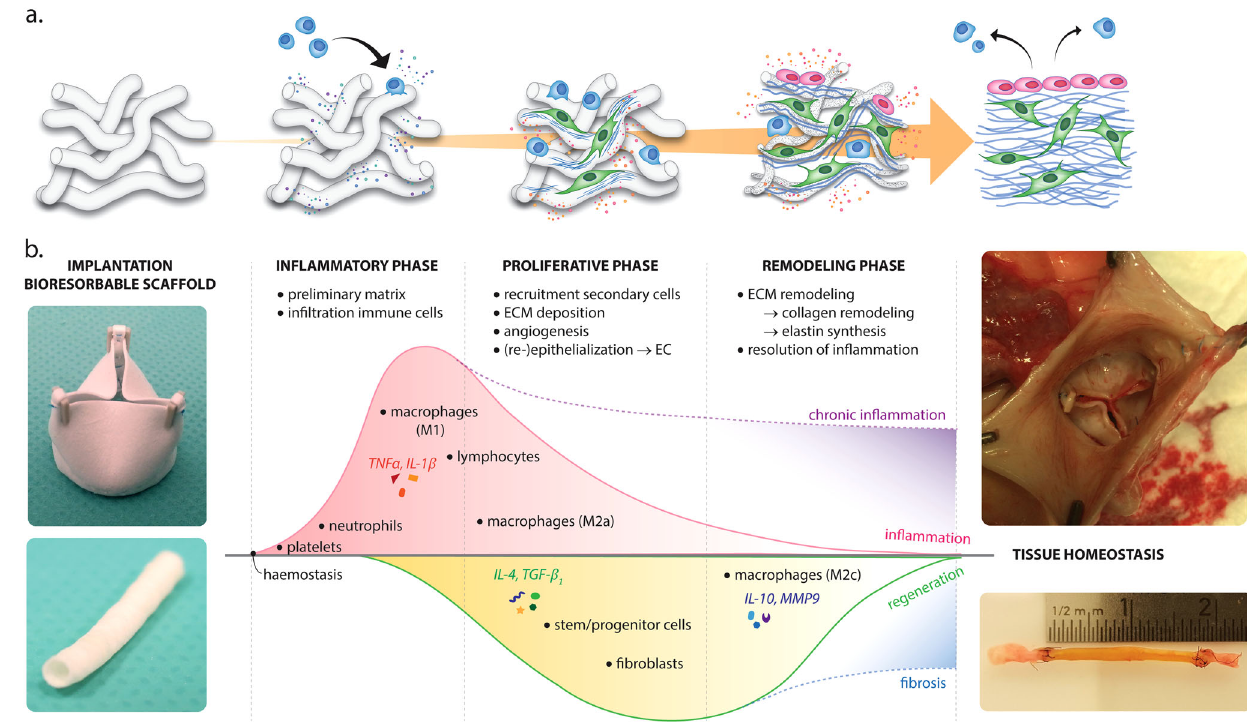
Fig. 1 Overview of the different stages of in situ tissue regeneration, going from a synthetic, biodegradable bare construct toward a viable substitute ( a ). Although many aspects underlying in situ regeneration remain unknown, it is hypothesized that the stages mirror the natural phases of the wound healing response ( b ), starting with the in fl ammatory phase, characterized by the in fi ltration of immune cells and the formation of a preliminary matrix. The subsequent proliferative phase is characterized by a secondary in fl ux of immune and tissue producing cells, extracellular matrix (ECM) deposition, angiogenesis and (re-)endothelialization of the construct. Tissue homeostasis is restored after a remodeling phase of the newly formed ECM and the resolution of in fl ammation. Photographs of heart valves adapted from; 33 photographs of vascular grafts courtesy of Renée